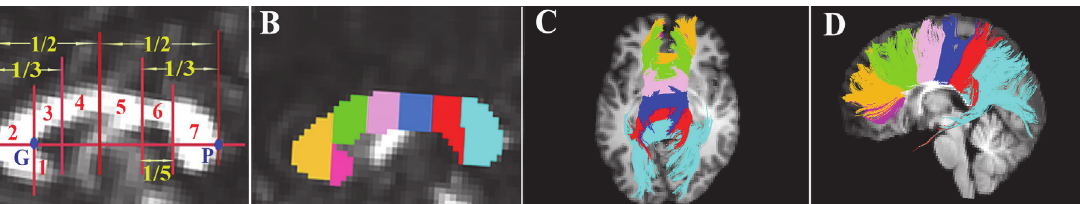
Fig 1. Sub-regions of the corpus callosum (CC). A , Mid-sagittal MR image of the CC showing the method (Witelson 1989) for defining 7 sub-regions. A and P indicate the anteriormost and posteriormost points of the CC. G, the anteriormost point on the inner convexity of the anterior callosum. A-P was used as the primary axis, lines perpendicular to which subdivide the CC into 7 sub-regions. B , Seven sub-regions were drawn as 7 seeds for fiber tracking. C and D , Fibers crossing through each seed on axial and sagittal anatomical